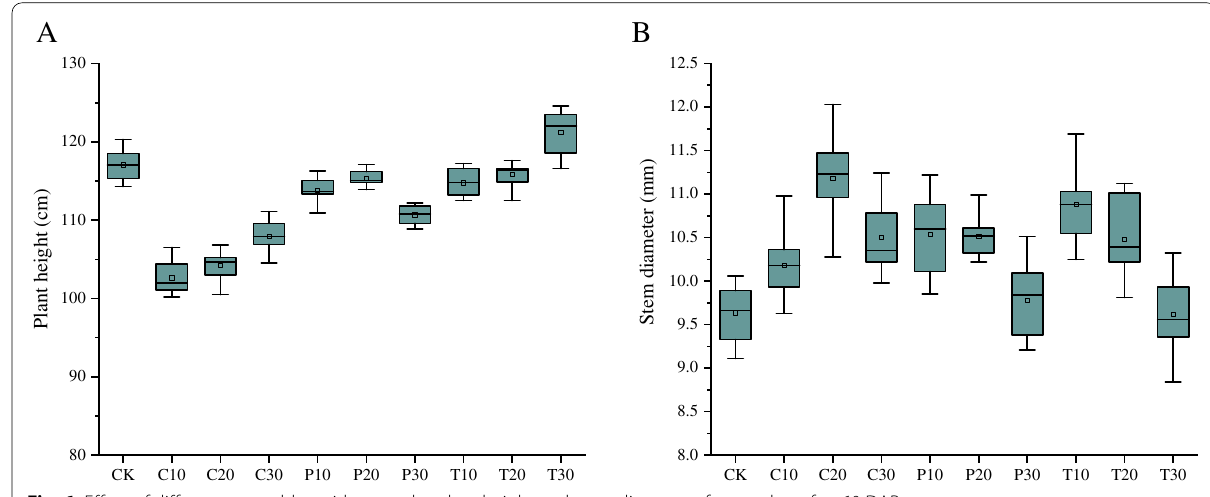
Fig. 6 Effect of different vegetable residues on the plant height and stem diameter of cucumber after 60 DAP